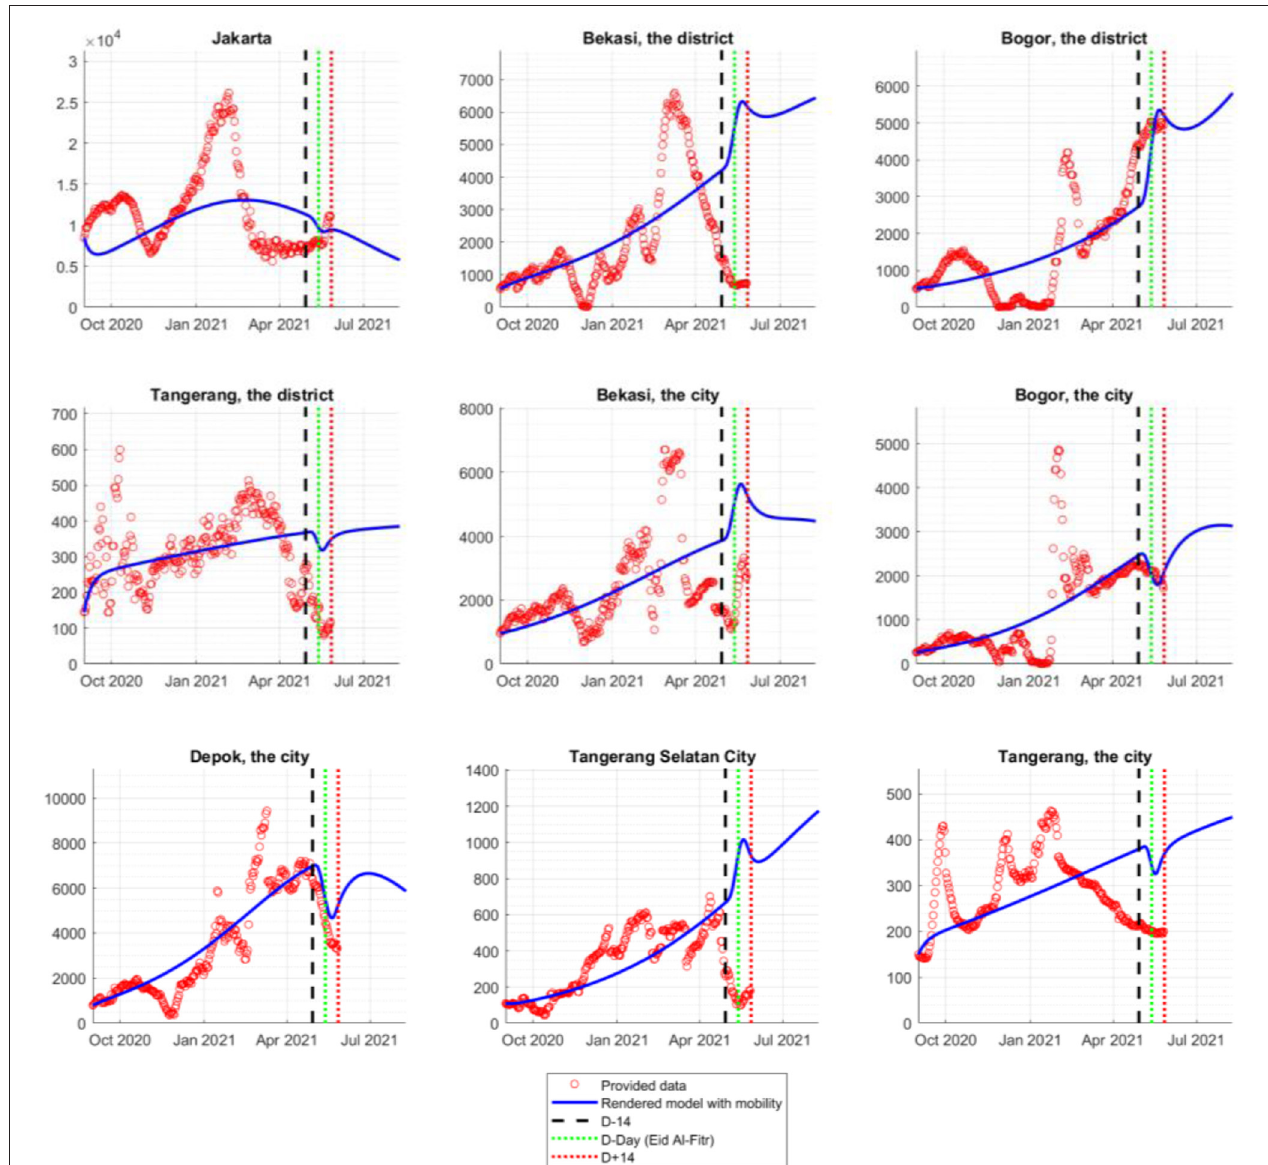
FIGURE 6 | Comparison of the actual data and the rendered model in Jabodetabek during the mass exodus of